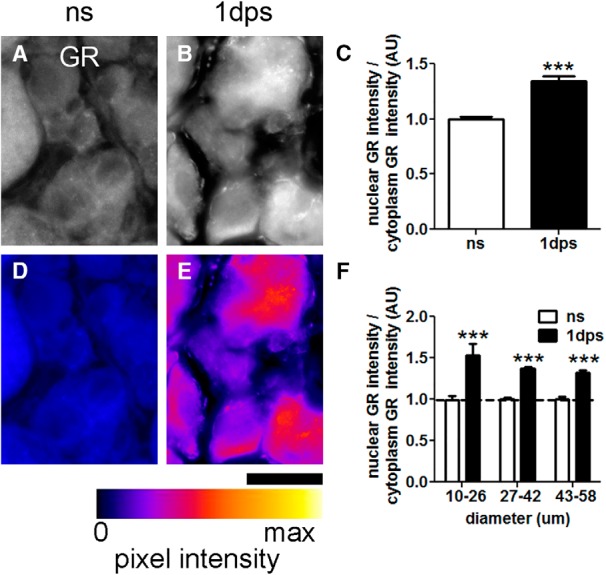
Stress increases GR nuclear localization in DRG neurons. A, B, GR immunofluorescence in DRG neurons from ns and stressed (1 d ps) mice. D, E, Images in A, B converted to an intensity map overlay using the Fire lookup table (ImageJ). Fire LUT pixel intensity map key show colors corresponding to pixels from 0 to max intensity. Scale bar, 25 µm. C, Stress increases nuclear GR pixel intensity in DRG compared to ns mice. N ≥ 50 neurons (see Materials and Methods). One-way ANOVA followed by Bonferroni post hoc tests, compared to ns. Mean and SEM are shown, ***p < 0.0001. F, Cell areas were divided into three groups to represent small (10-26 µm), medium (27-42 µm), and large (43-58 µm) DRG neurons. Increases in GR nuclear localization were consistent across different sized DRG neurons.